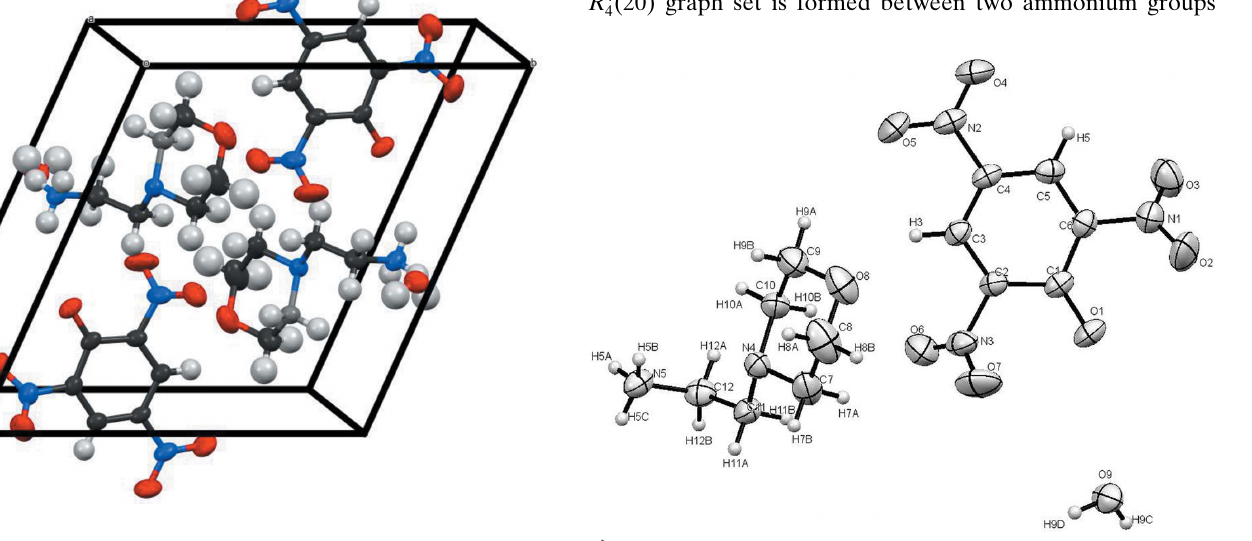
Figure 1 Molecular diagram of the title compound viewed down along a * axis in the unit